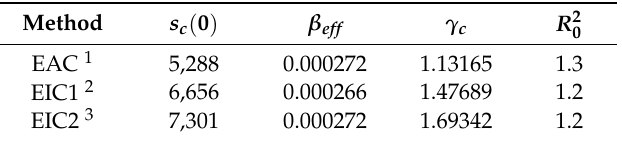
Table 5. Model parameter estimates for Tolima, Colombia (first outbreak) .